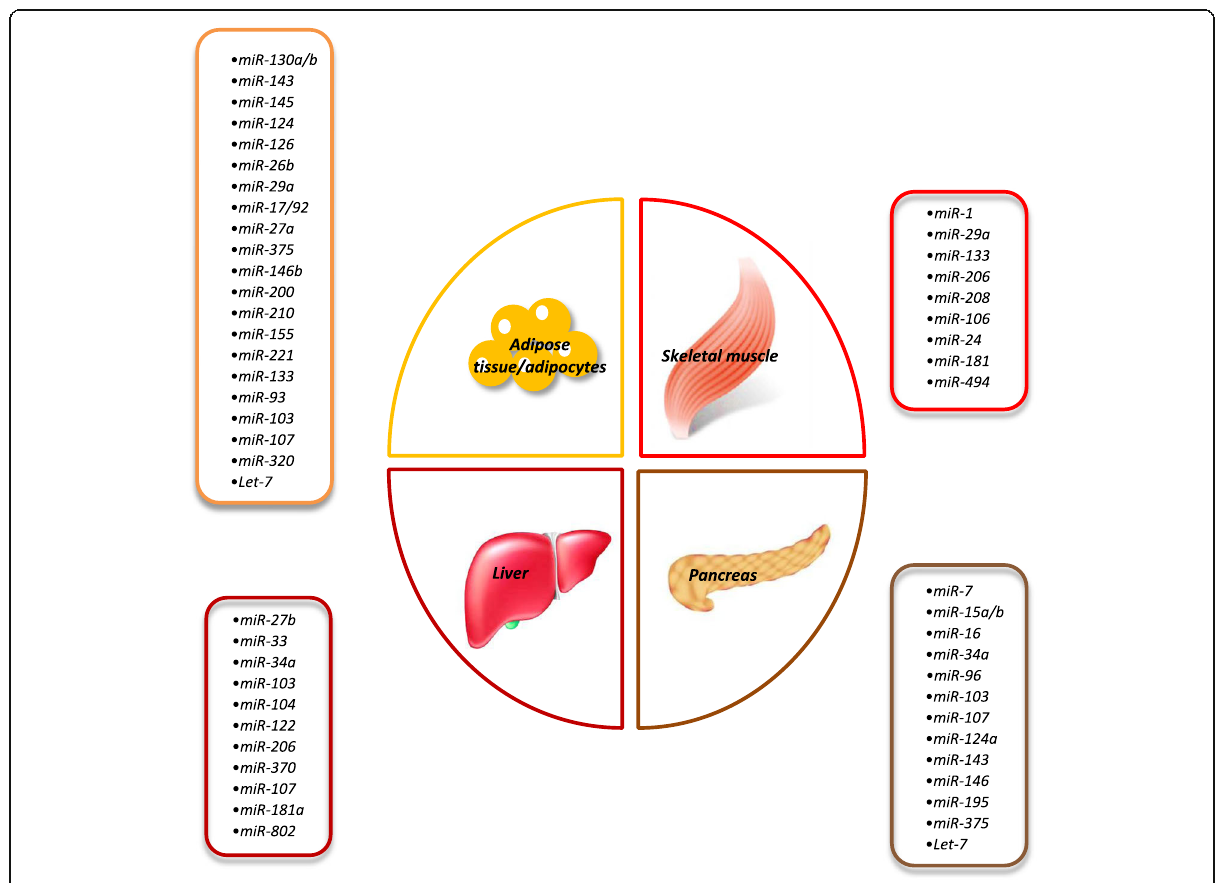
Fig. 2 Overview of miRNAs possibly associated with obesity and metabolic diseases in different tissues. Circulating miRNAs are additionally reported in Table